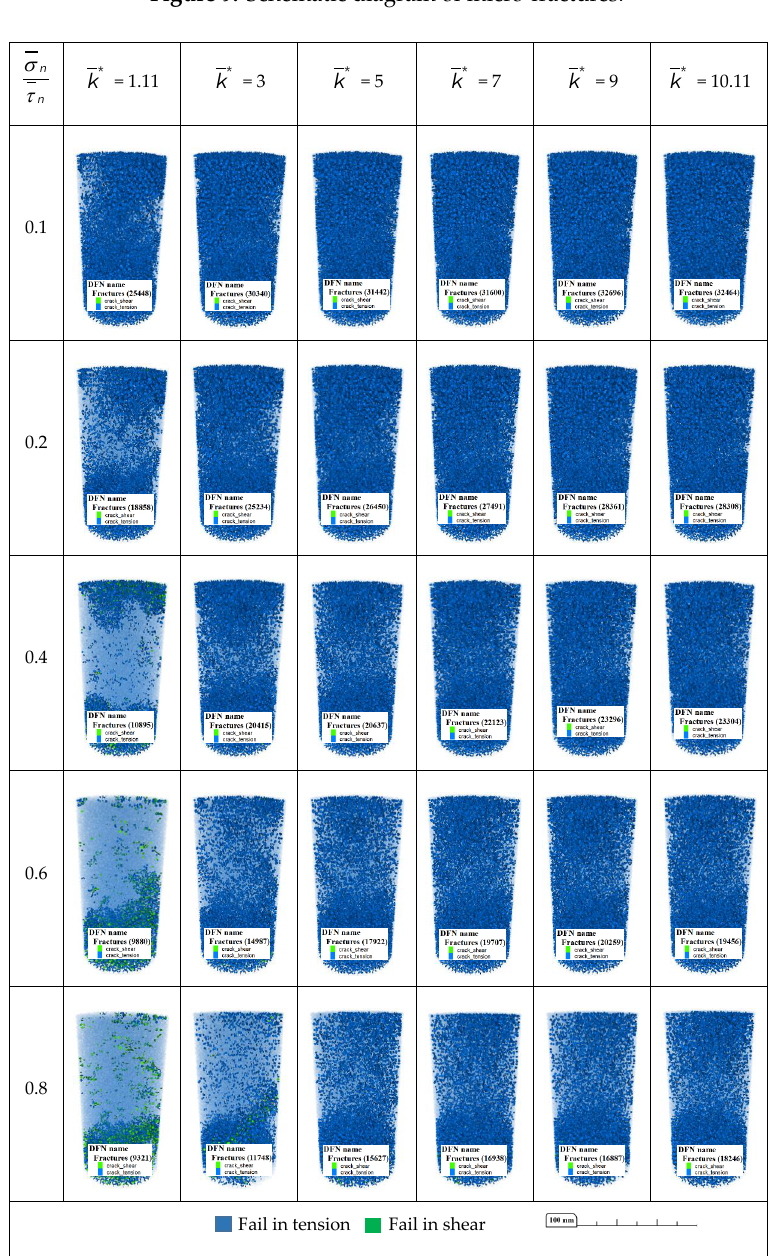
Figure 9. Schematic diagram of micro-fractures.